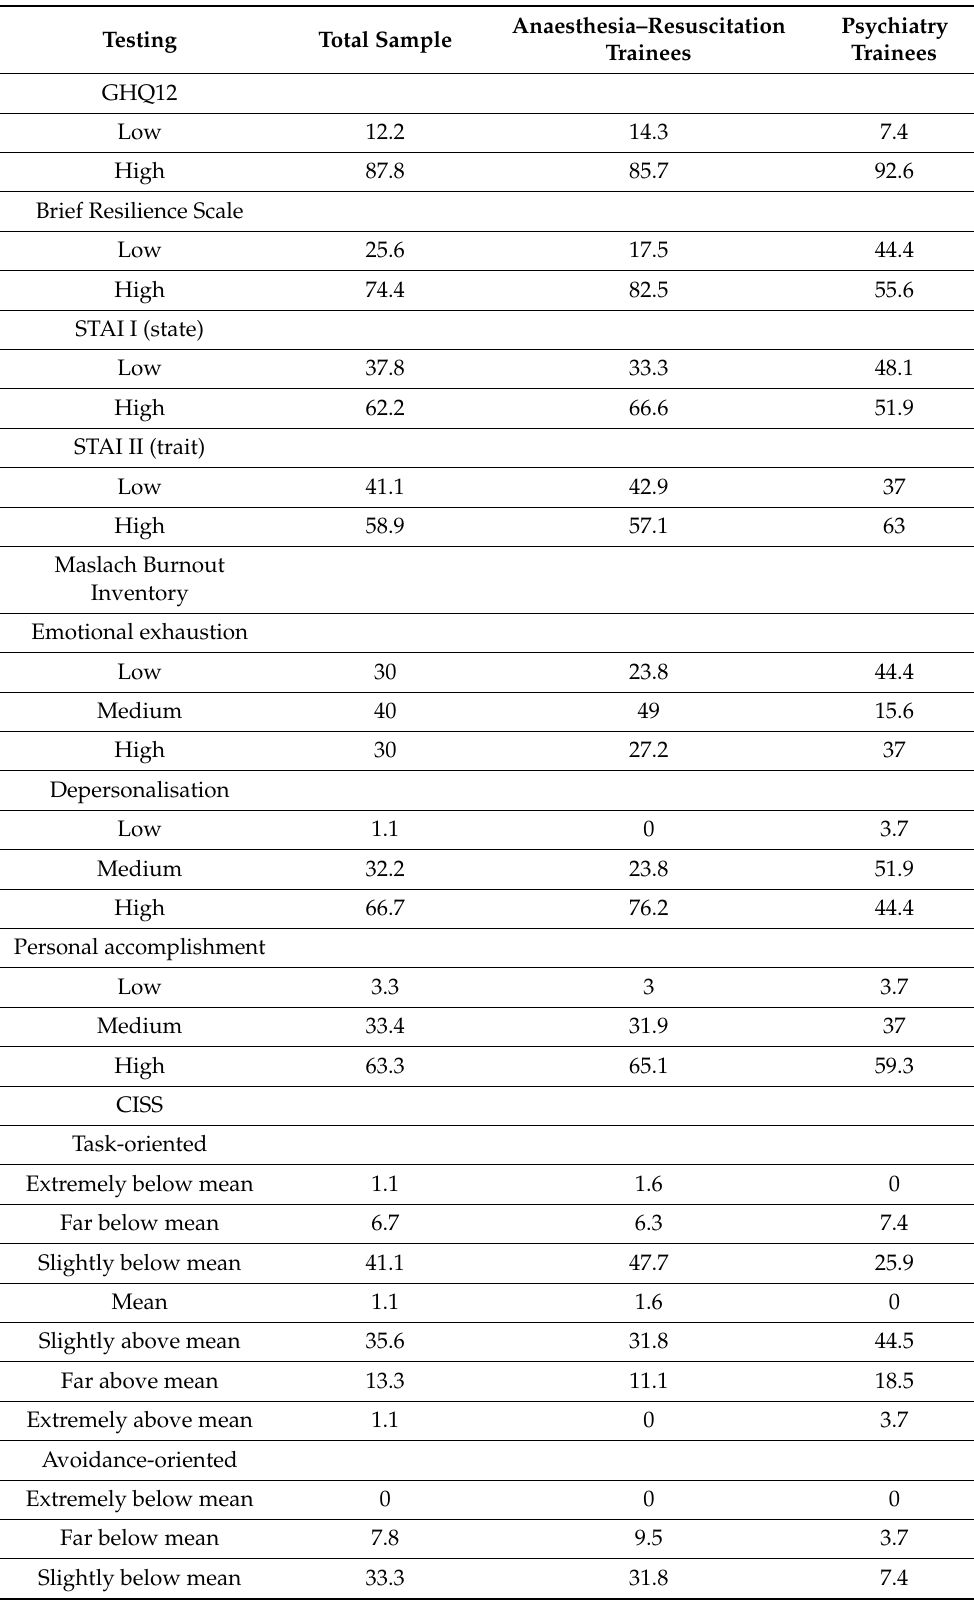
Table 3. Cut-off point percentages in total sample, anaesthesia–resuscitation trainees, and psychia- try